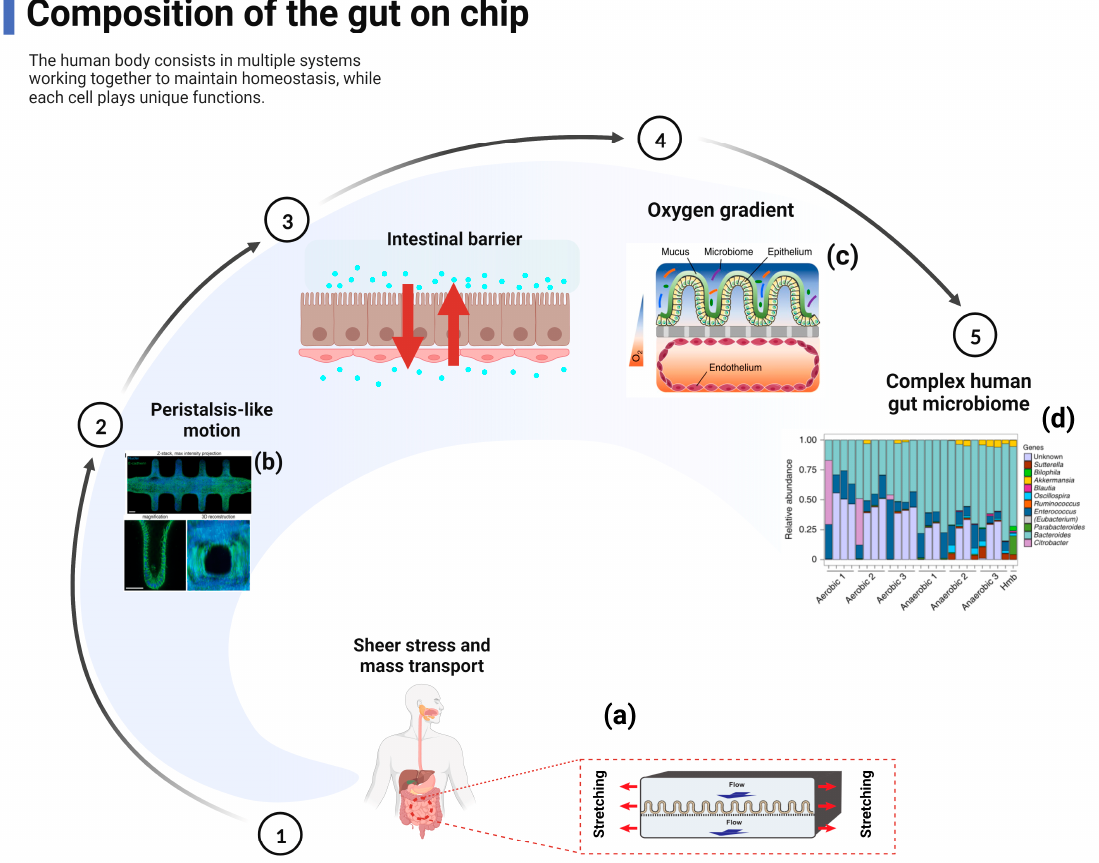
Figure 3. The gut-on-chip reproduces the composition and function of the gut. Main relevant repro- duced include shear stress and mass transport, peristalsis-like motion, intestinal barrier, and oxygen gradient. ( a ) Gut-on-chip reveals mechanical forces impacting Shigella infection [49] ©Copyright 2019, Cell Press; ( b ) Bioengineering intestinal stem cell epithelia with a tubular, in vivo-like architecture [29] ©Copyright 2020, Nature; ( c ) A schematic of the two-channel gut-on-chip device with an oxygen gradient [44] ©Copyright 2019, Nature; ( d ) Differences in microbial abundance between gut-on-chip samples and a human microbiome stool sample from the Human Microbiome Project [44] ©Copyright 2019, Nature.